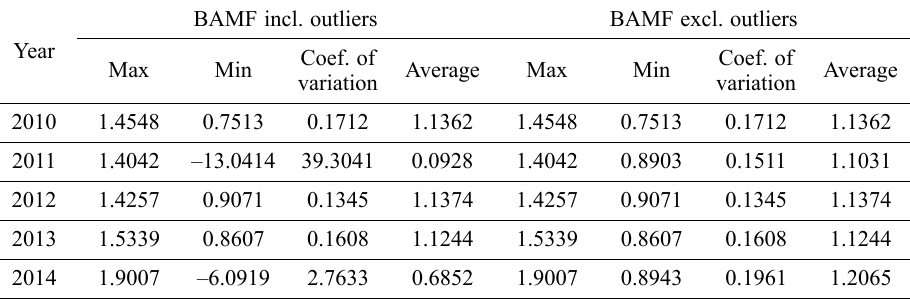
Table 1. Selected characteristics of aggregate BAMF